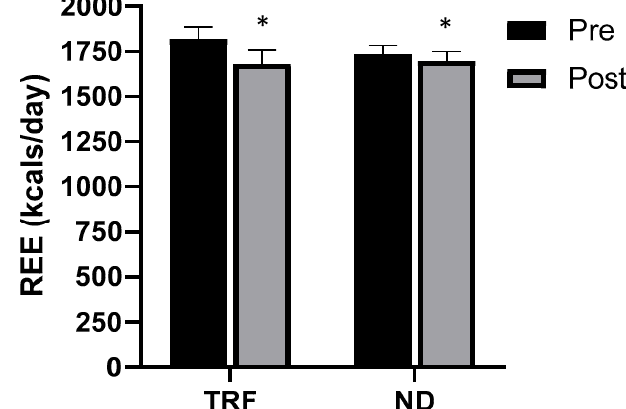
Figure 3. Resting energy expenditure (REE) pre and post four week intervention for both the time-restricted feeding (TRF) and normal diet (ND) groups. Error bars reflect SEM. * = main effect for time.